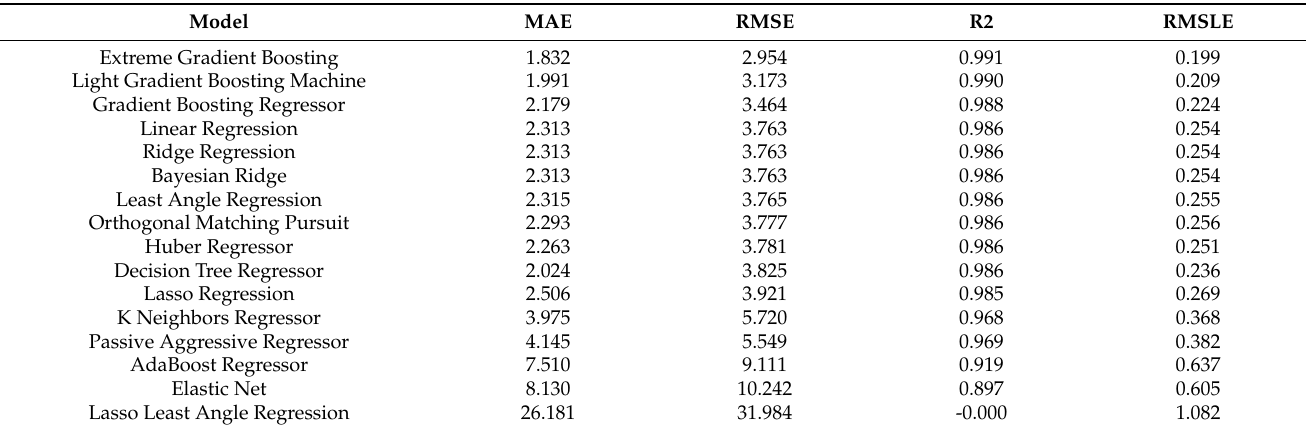
Table A3 shows the results for the different ML regression algorithms obtained for the Pure model. Table A3. Regression metrics for the Pure model.